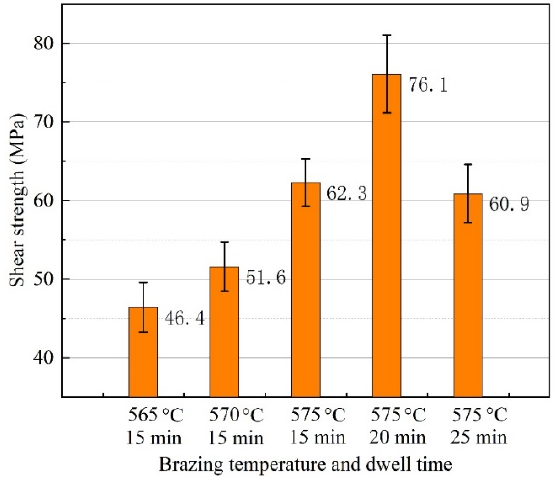
Figure 10. Shear strength of the joint brazed at different temperature and dwell time.